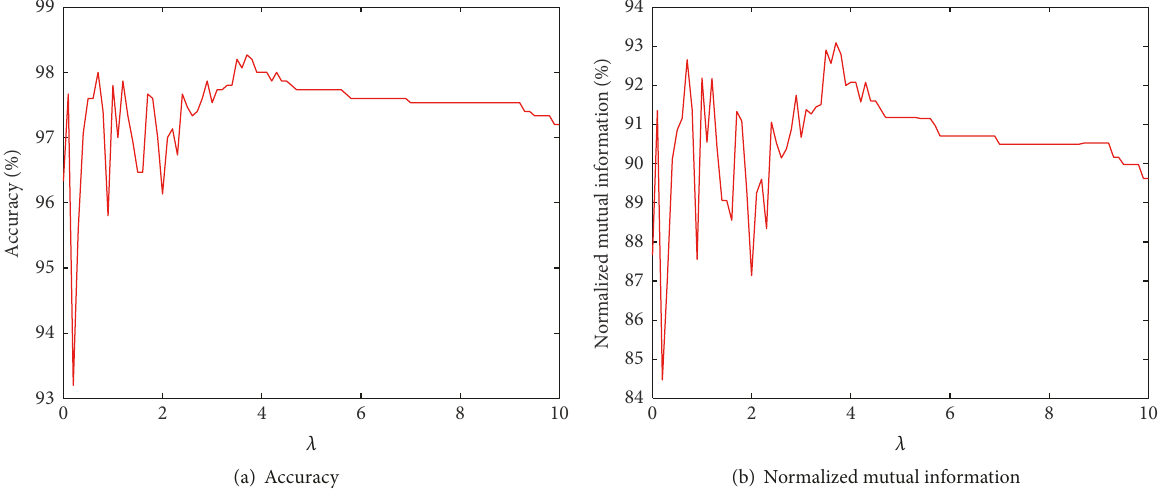
Figure 2: The performance of GSNMF versus different 𝜆 on IRIS data set.